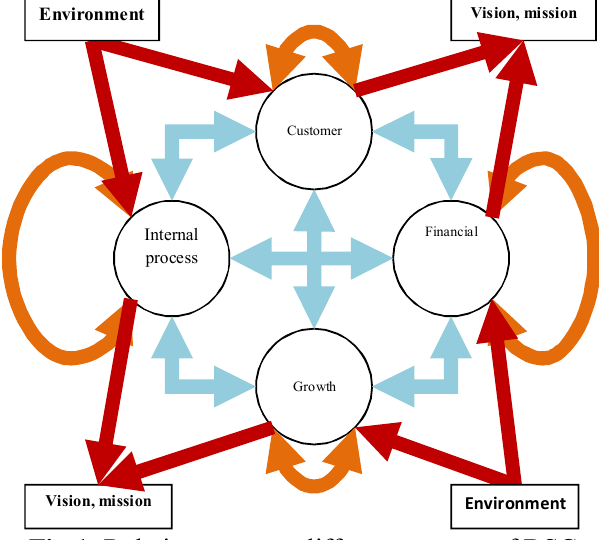
Fig.1. Relations among different aspects of